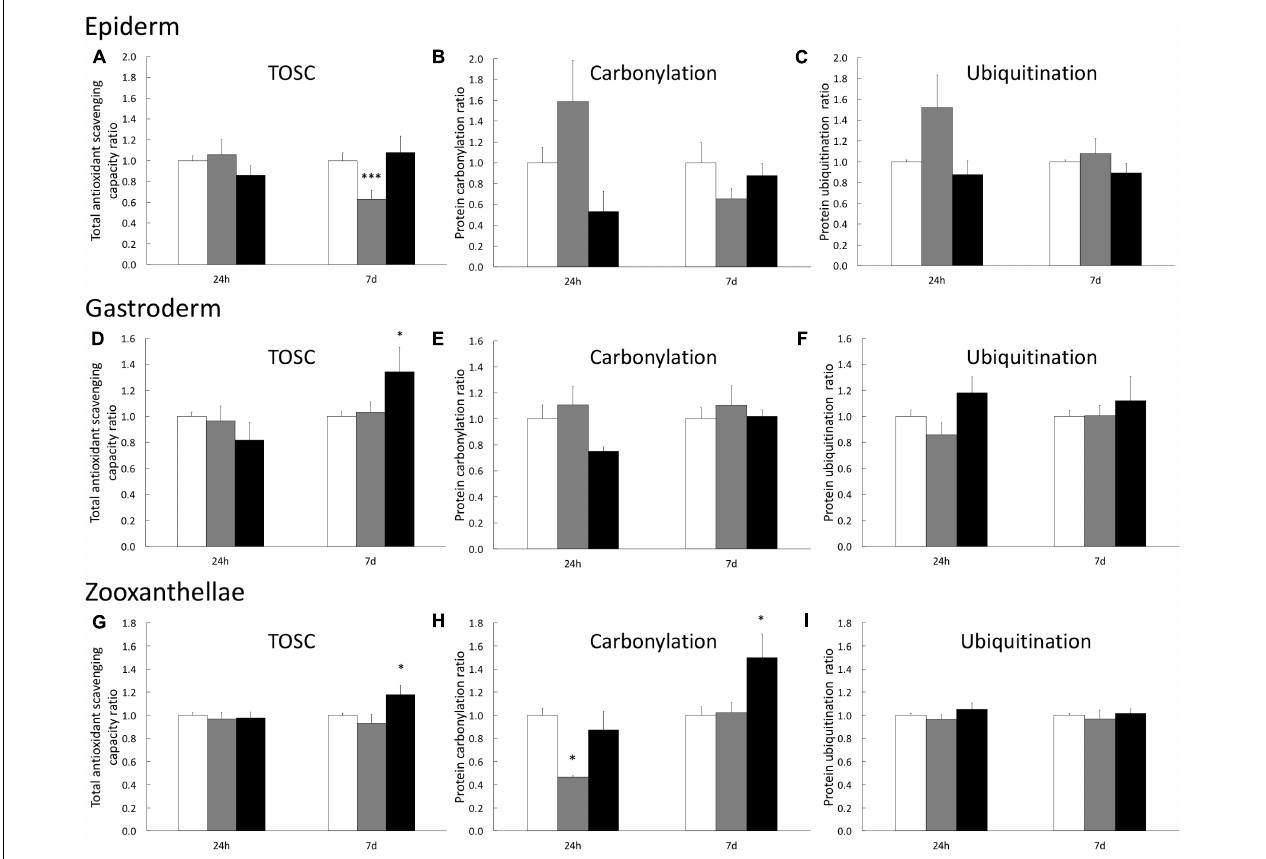
FIGURE 2 | Stress biomarkers in A. viridis tissues under H 2 O 2 treatments. Measurements have been performed separately on animal’s epiderm extracts (A–C) , on animal’s gastroderm extract (D–F) and on symbiont extracts (G–I) from the gastroderm. Total Oxidative Scavenging Capacity (A,D,G) , protein carbonylation (B,E,H) and protein ubiquitination (C,F,I) were measured under 0 µ M H 2 O 2 (control; white bars), 200 µ M H 2 O 2 (gray bars) and 500 µ M H 2 O 2 (black bars). Data are expressed relative to the control condition (ratio of the control condition). Means values with standard error bars are presented. Significant differences between control and stress condition are expressed by ∗ p < 0.05 and ∗∗∗ p <